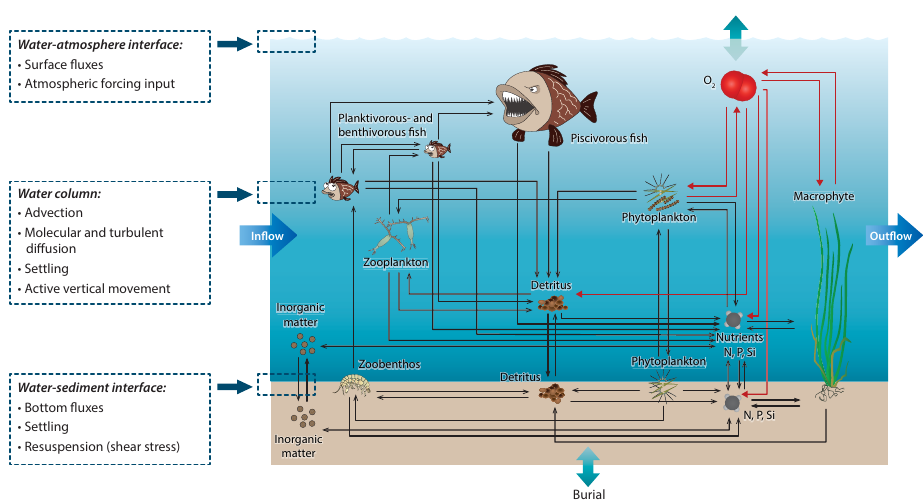
Figure 1. Conceptual model of FABM-PCLake (FABM, Framework of Aquatic biogeochemical Models; PCLake, the implemented aquatic ecosystem model). Key state variables of the FABM-PCLake biogeochemical model and the interactions between these (represented by arrows); and an indication of how a physical model may now transport biogeochemical state variables through explicit physical